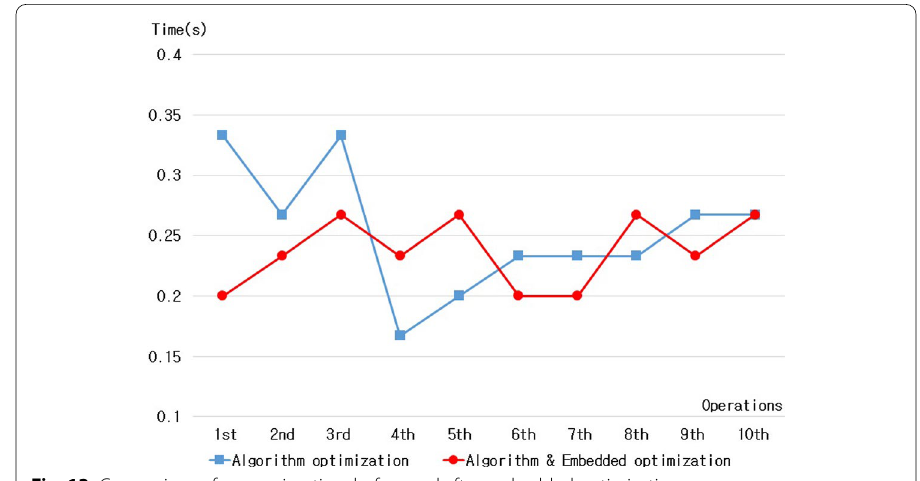
Fig. 13 Comparison of processing time before and after embedded optimization